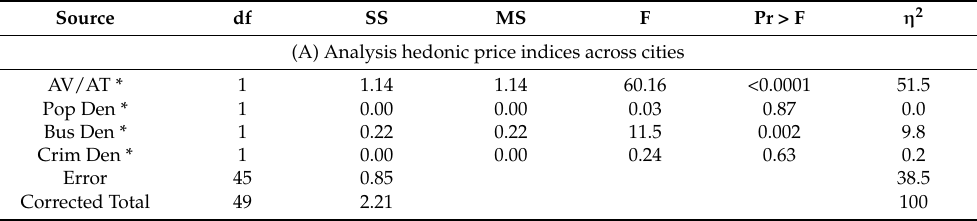
Table 2. (A) Summary statistics for the multiple regression models in which (A) real estate prices were correlated with four variables: green space, population density, business density and crime rate, (B) green space and green patch attributes vs. real estate prices in Lima, and (C) green space and green patch attributes vs. real estate prices in Buenos Aires. Variables: Av/at = green space/total area, TGS = Total green space, TNP = Total number of patches, MPS = Mean patch size, LPS = Largest patch size, ANN = average nearest neighbor, PopDen = Population Density, BusDen = Business Density, CrimDen = Crime